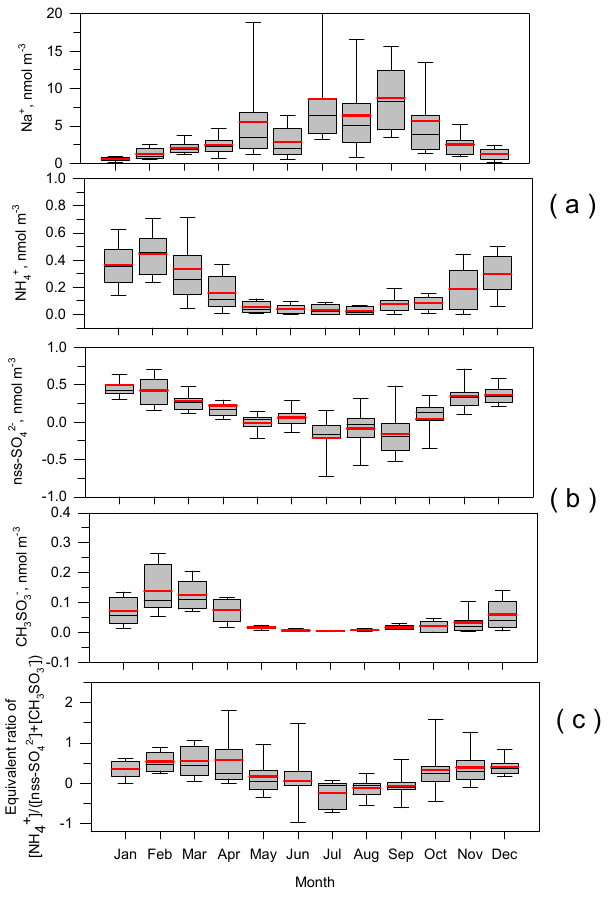
Fig. 5. Seasonal variation of the concentrations of NH + , nss- 4 SO 2 − , and CH 3 SO − , and the equivalent ratio of NH + /(nss- 4 3 4 ) in aerosol particles with size of D p < 0 . 2µm at SO 2 − +CH 3 SO − 4 3 Syowa Station. Concentration of nss-SO 2 − was estimated using 4 Na + concentration and the bulk seawater ratio (Wilson, 1975). In box plots, the upper bar, upper box line, black middle box line, bot- tom box line, and bottom bar respectively denote values of 90%, 75%, 50% (median), 25% and 10%. The red line represents mean